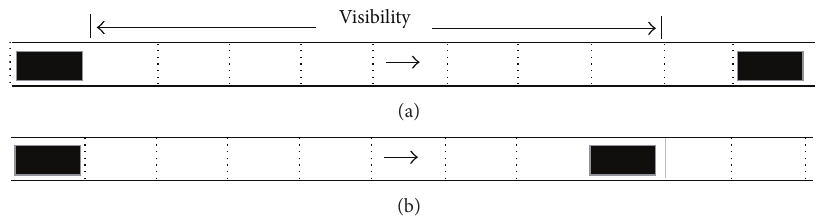
Figure 1: Diagram of the CA model in heavy fog. Note: the single arrows in the figure show the driving